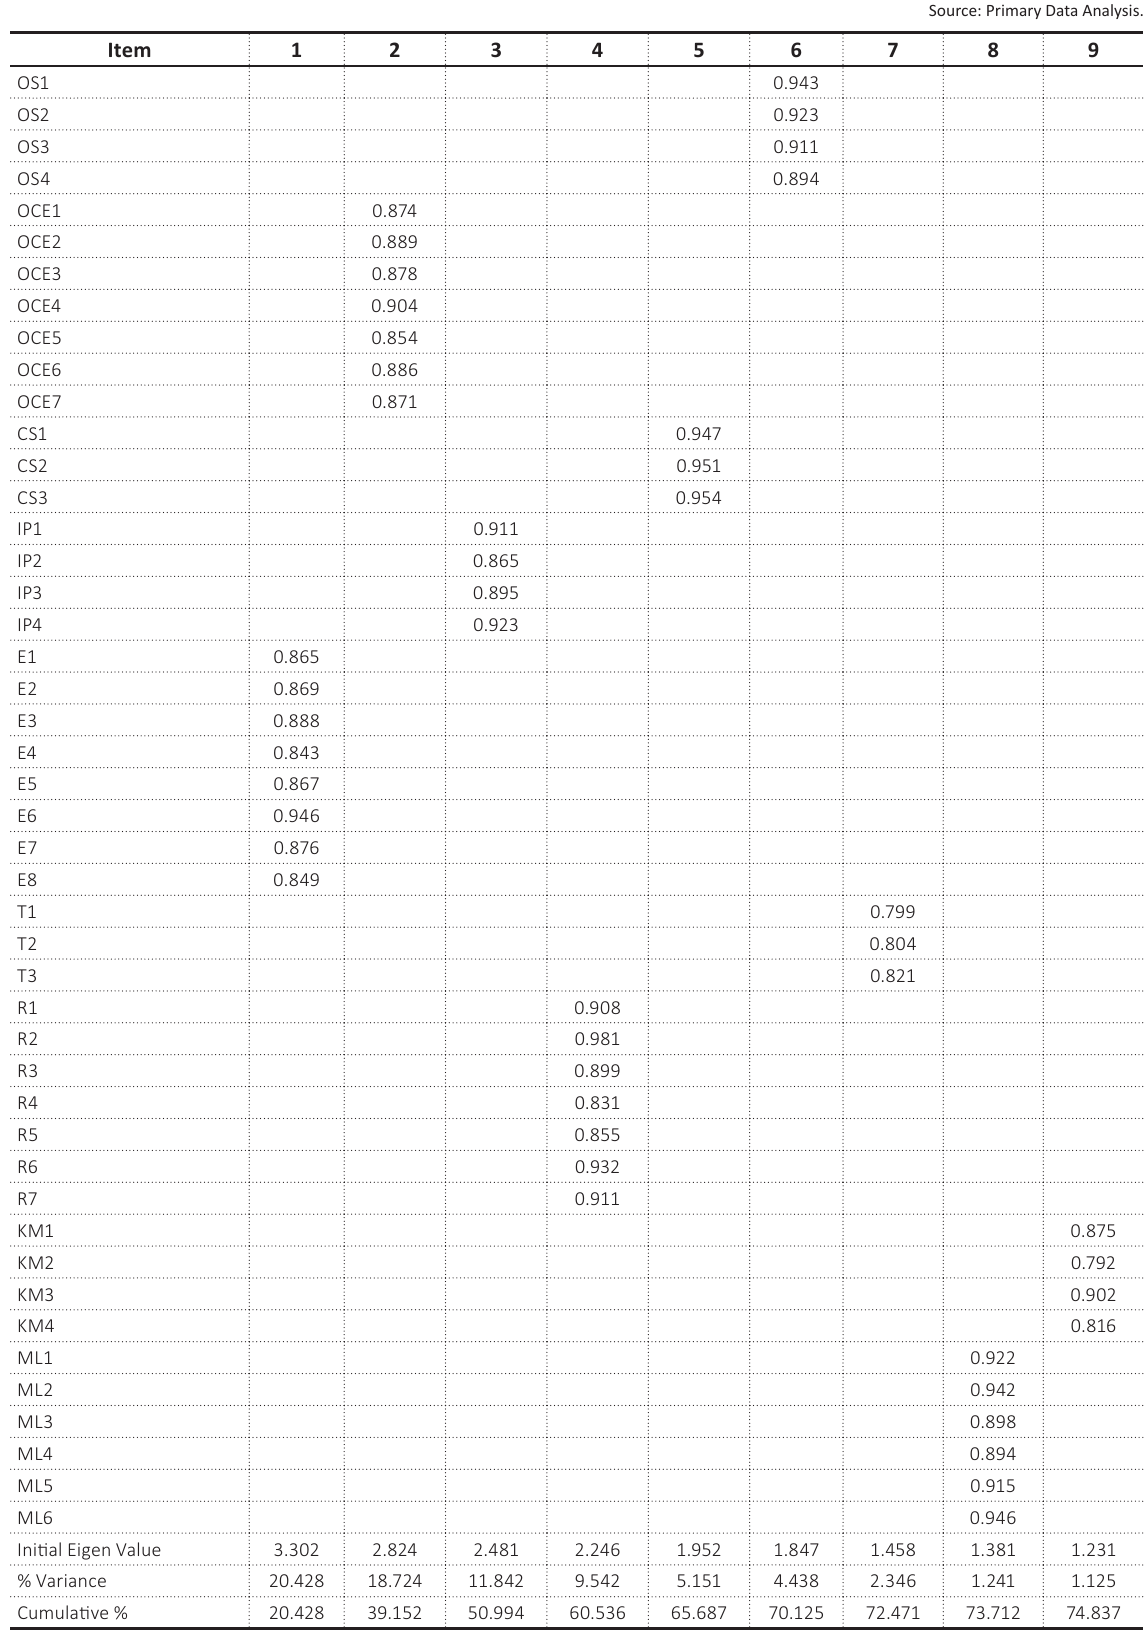
Table 3. Rotated factor matrix